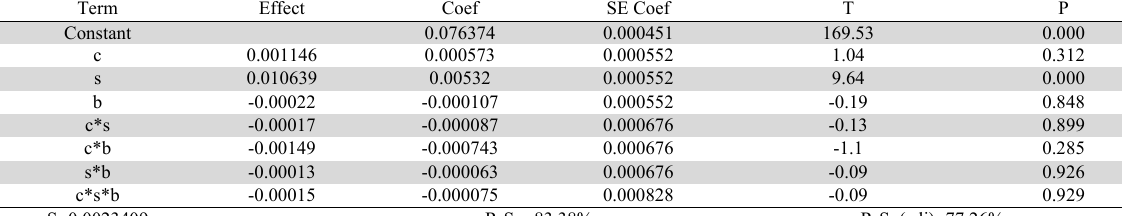
Estimated effects and coefficients for the raw material sales price Term